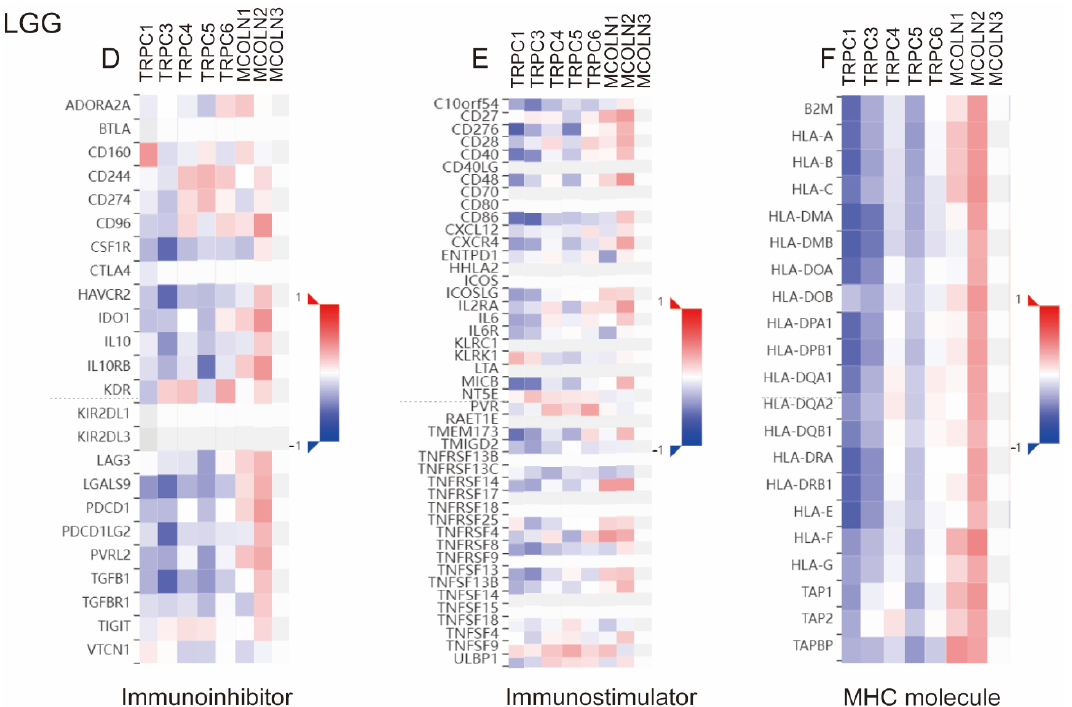
Figure 8. Correlations Between Hub Genes and the Expression of Immunoregulators in Glioma. The correlation between the expression of TRPC1, TRPC3, TRPC4, TRPC5, TRPC6, MCOLN1, MCOLN2, and MCOLN3 and immunoinhibitors ( A , D ), immunostimulators ( B , E ), and MHC molecules ( C , F ) was calculated based on the TISIDB database.